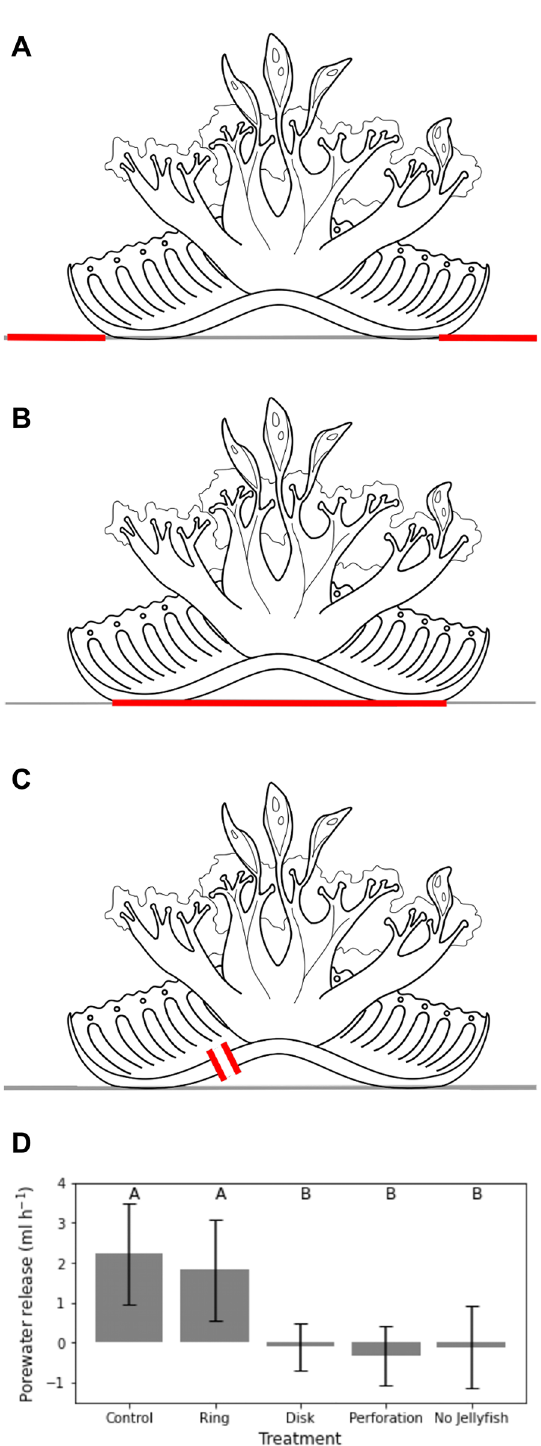
Figure 2. Porewater barriers. Release of porewater was highest in the control group and ring treatments, and absent in both the disk and perforation treatments, as well as the trials without jellyfish. Besides an unaltered control treatment, experimental treatments consisted of ( A ) an impermeable ring surrounding the animal, ( B ) an impermeable disk below the bell, and ( C ) a 6 mm perforation through the bell into the exumbrellar cavity. ( D ) Differences between treatments were found to be significant (one-way Anova, f = 8.61, p < 0.0001) and post- hoc comparisons showed that the two treatments with high porewater release rate ( A ) and low porewater release rates ( B ) were not significantly different within groups, but significantly different between groups (Tukey HSD, α = 0.05). Negative values in low-release treatments ( B ) are likely due to diffusion of fluorescein inadvertently released during experimental setup into the clean cap